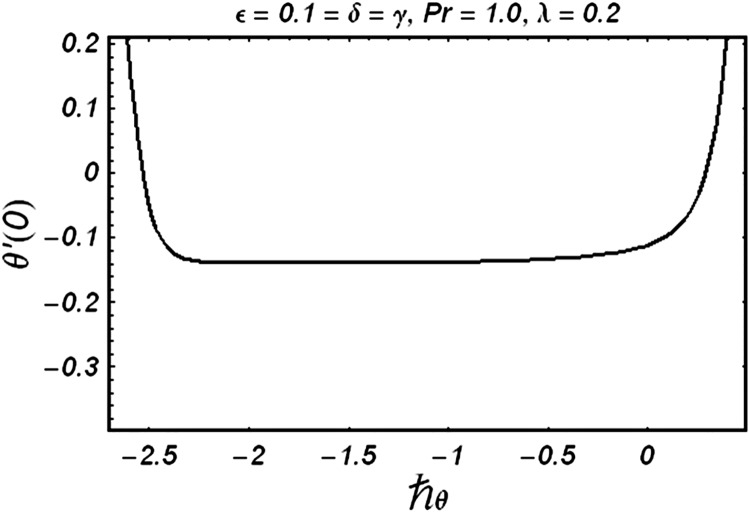
ℏθ curve for temperature.